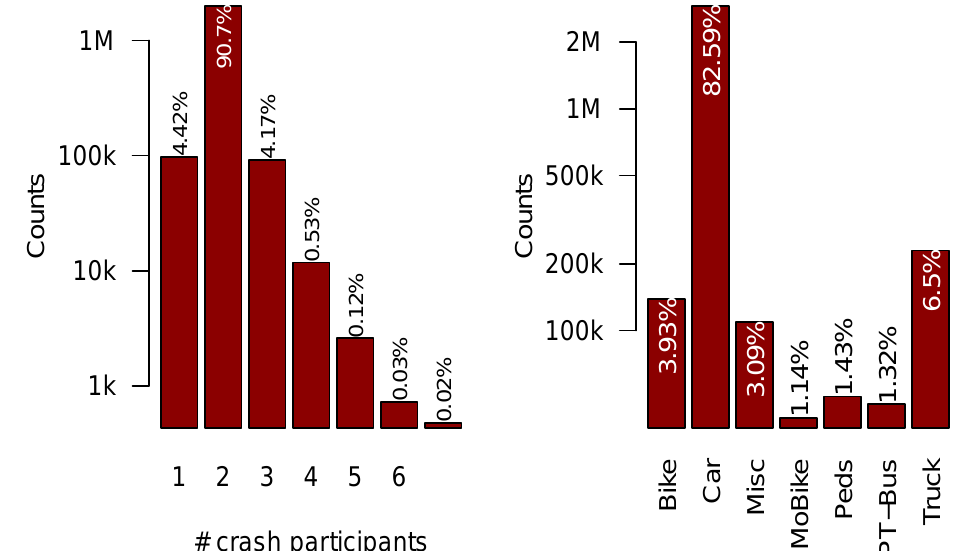
Figure 1. Distribution of the number of road users involved ( left ), and the traffic shares ( right ) in the Berlin crash data set. The Misc traffic mode is being used by the police to denote any traffic mode that cannot be assigned. The y -axis is logarithmic, the numbers on top of the bars are the percentages of the respective